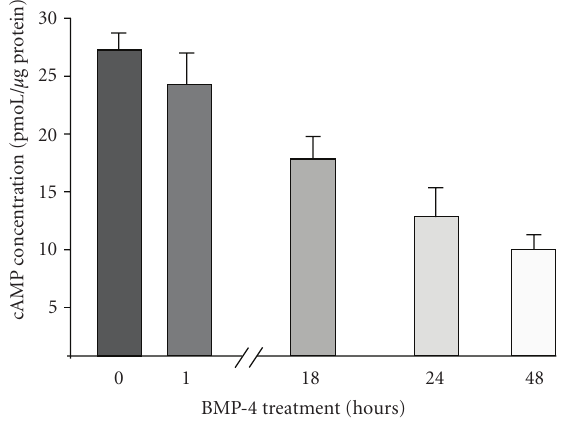
Figure 5: BMP-4 decreases the intracellular level of cAMP . Paired cultures of melanocytes were treated with BMP-4 for 0, 1, 18, 24, and 48 hours. At each time point, cells were harvested and the level of intracullelar cAMP level was determined. One representative result from three separate experiments is